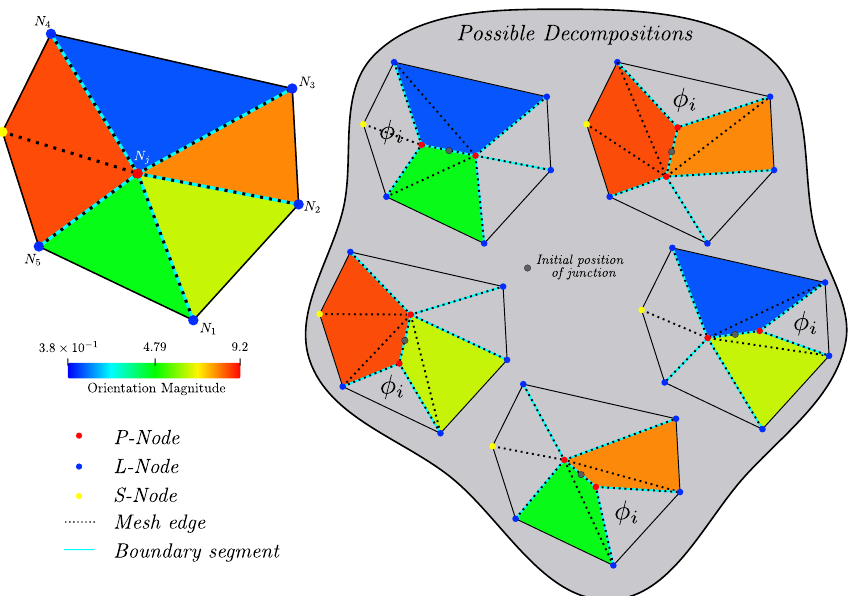
Figure 1. Possible decompositions of a fifth-order MJ. Data regarding the orientation of each grain are given. One possible decomposition for every phase involved is depicted. The decomposition of a